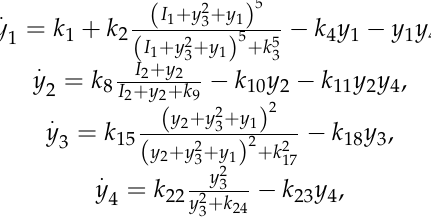
where y 1 , y 2 and y 3 are three mRNAs (mOlig2, mSox9 and mSox10), and where y 4 repre- sents the unification of four microRNAs (miR-17/335/338/155, respectively). According to [14] (Table S5 in Supplementary Materials), k 7 = k mSox 9 BS ≈ 0; g = 5.24 ≈ 5; g = 1.39 ≈ 1; g = 1.88 ≈ 2; 0.0015 ≈ 0; k 21 = k miRNA Sox 9 Sox 10 Olig 2 BS = 0.8 ≈ 1, g mir 338 = 0.9738 ≈ 1; g mir 335 = 0.87 ≈ 1; g mir 155 = 1; g mir 17 = 0.99 ≈ 1; g Tcf 712 and g Myrf = 1.46 ≈ 1. Here, we note that (i) in (1), the following substitutions are accepted: k si ≈ 1 ( i = 1, 2, 3 ) ; (ii) all model parameters are taken from [14] Pr otX i = α i . mRNA , α i = k di (cid:2) (cid:3) h − 1 with dimension , and input Shh = I 1 and input BMPs = I 2 are antagonistic signals (morphogen gradients). The model (1) is considered to be a four-dimensional nonlinear dynamical system.